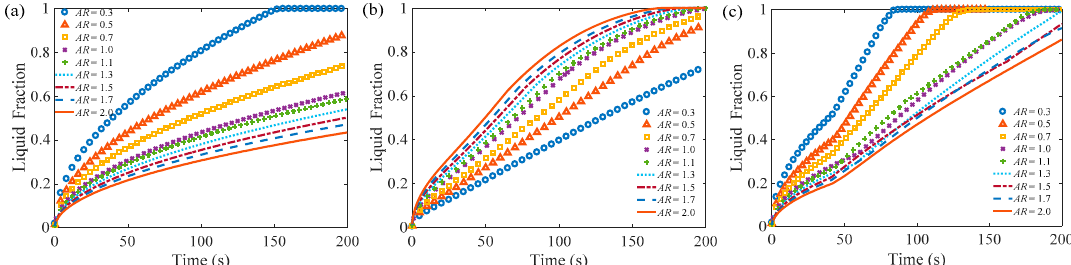
Figure 10. Evolution of the liquid fraction of the phase change material (PCM) in rectangular enclosures with different aspect ratios by heating the different sides. ( a ) Heating the top side; ( b ) heating the right side; ( c ) heating the bottom side.